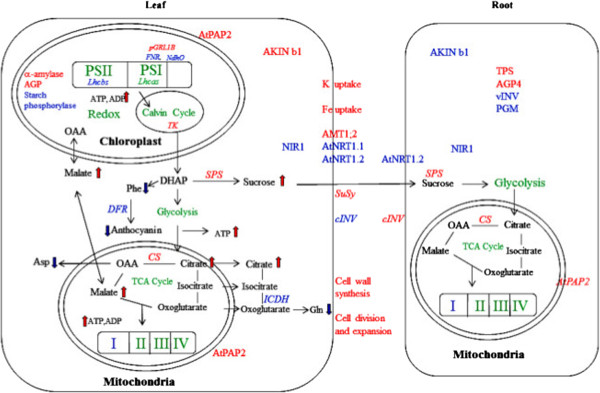
Summary of the microarray data in leaves and roots. Transcripts (italic) up-regulated and down-regulated in AtPAP2 OE plants are indicated in red and blue colors, respectively. Metabolites increased or decreased are indicated by red and blue arrows, respectively. Pathways in green means “not significantly changed”. I-IV, mitochondria complex I-IV; AKINb1, β1 subunit of SNRK; AGP, ADP-glucose pyrophoshorylase; cINV, cell wall invertase; CS, citrate synthase; DFR, dihydroflavonol 4-reductase; DHAP, dihydroxyacetone phosphate; ICDH, isocitrate dehydrogenase; OAA, oxaloacetate; PGM, phosphoglucomutase; PSI, photosystem I; PSII, photosystem II; SuSy, sucrose synthase; SPS, sucrose phosphate synthase; TK, transketolase; TPS, trehalose-6-phosphate synthase; vINV, vacuolar invertase.